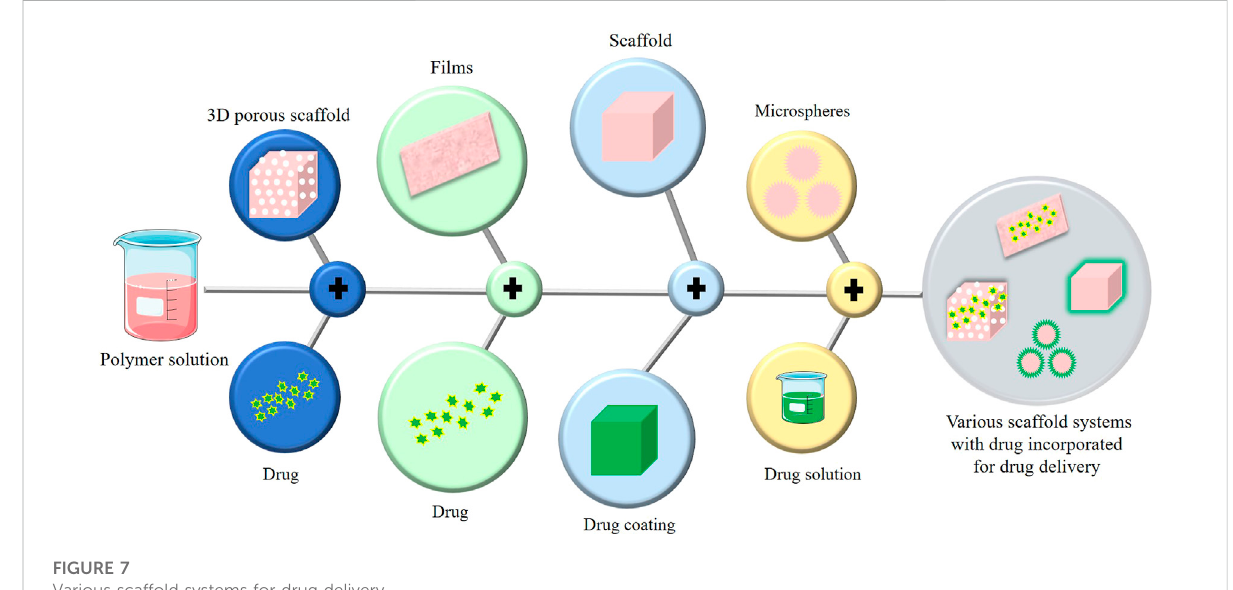
FIGURE 7 Various scaffold systems for drug delivery.